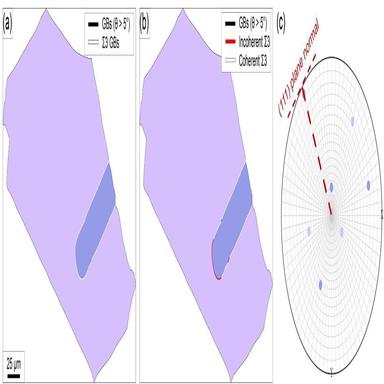
(a) Identified Σ3 GBs (coloured white) within the Brandon criterion; (b) coherent (coloured white) and incoherent Σ3 (coloured red) boundaries differentiated by measuring angles between GB traces and (c) common (111) plane trace.